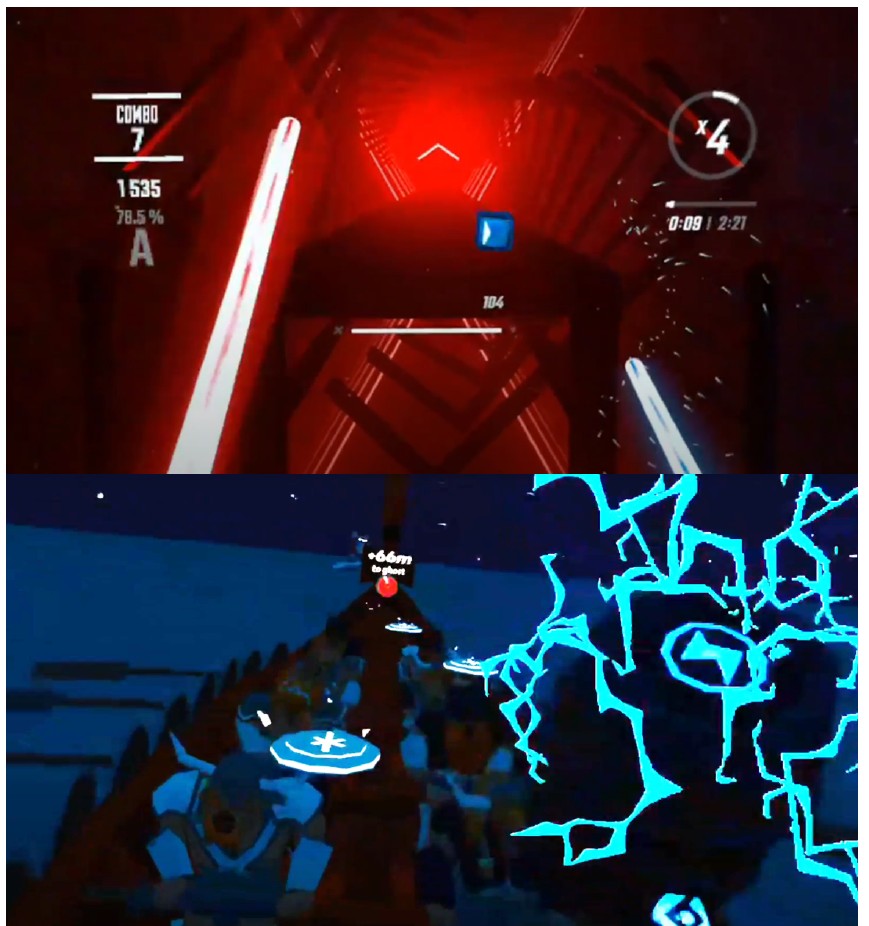
Figure 1. Screenshots of the two games used in this study. Top: Beat Saber—using laser swords to slice blocks in time with music. Bottom: Ragnarock—using hammers to hit drums in time with